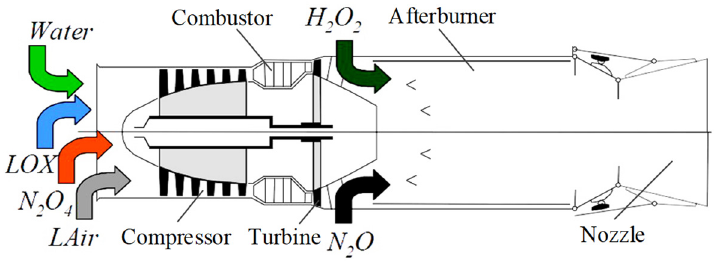
Figure 1. Configuration of an MIPCC engine.